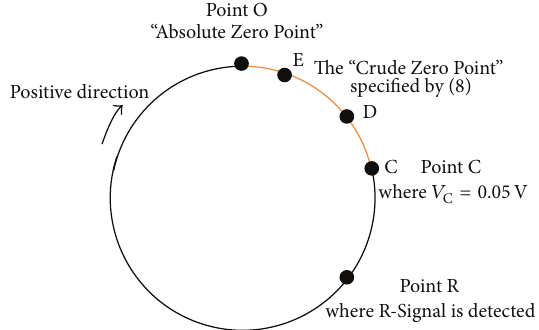
Figure 4: Error analysis for R-Signal